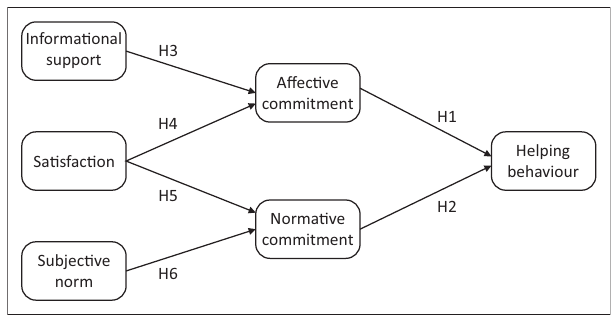
FIGURE 1: Conceptual model.